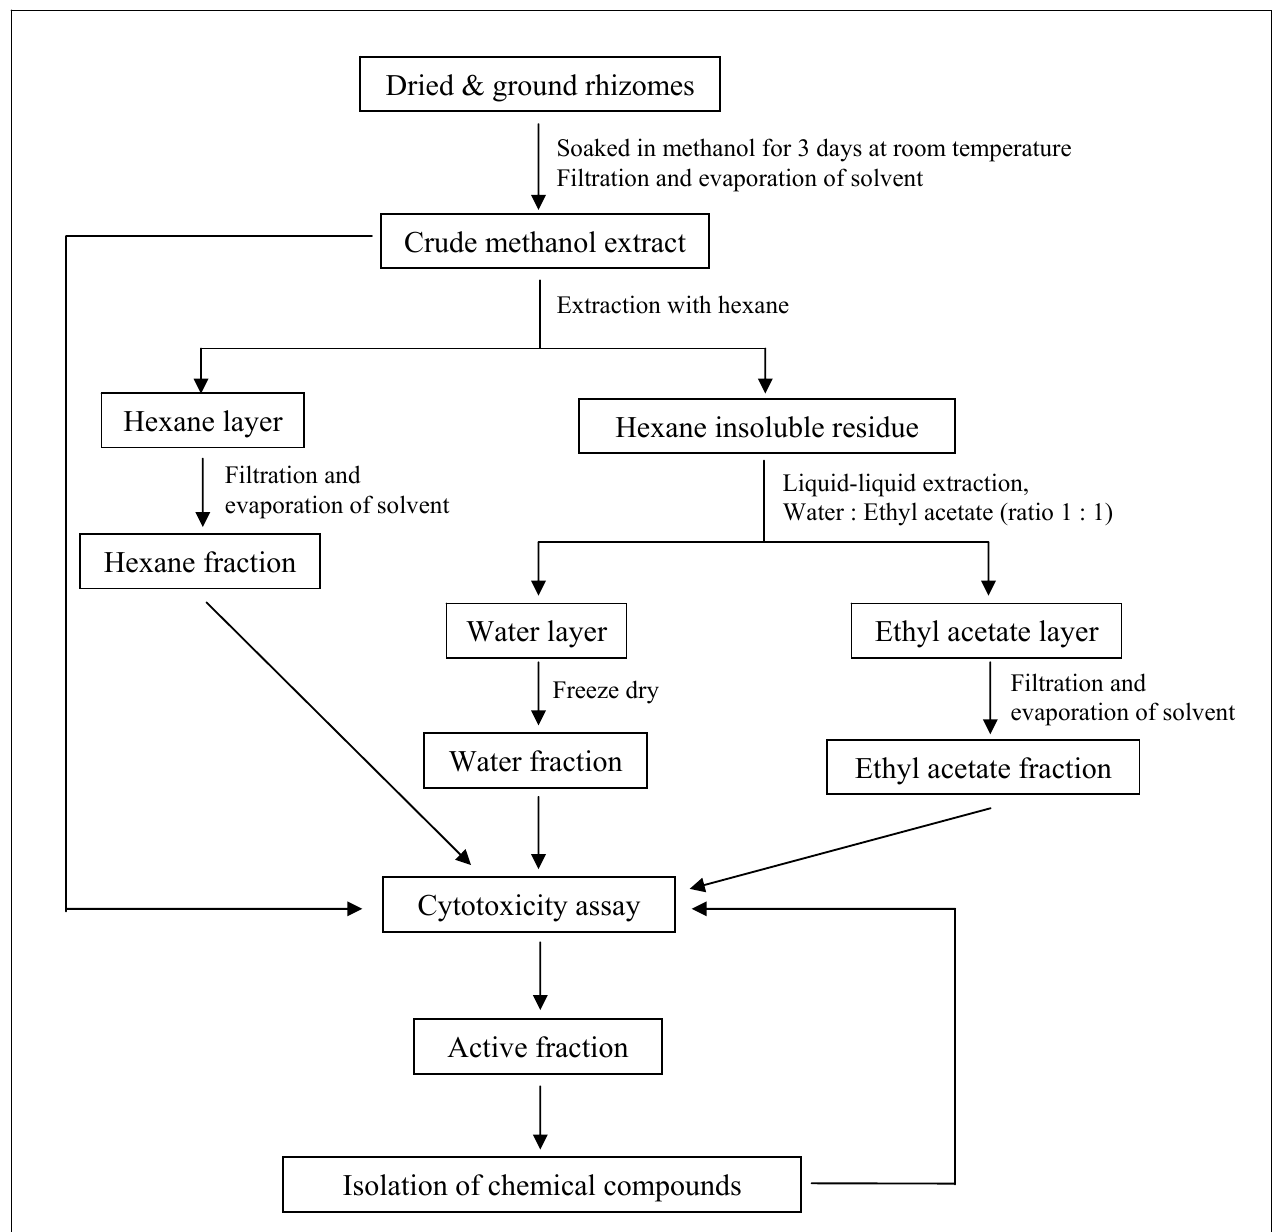
Figure 2. Procedures in the bioassay-guided chemical investigation of C.